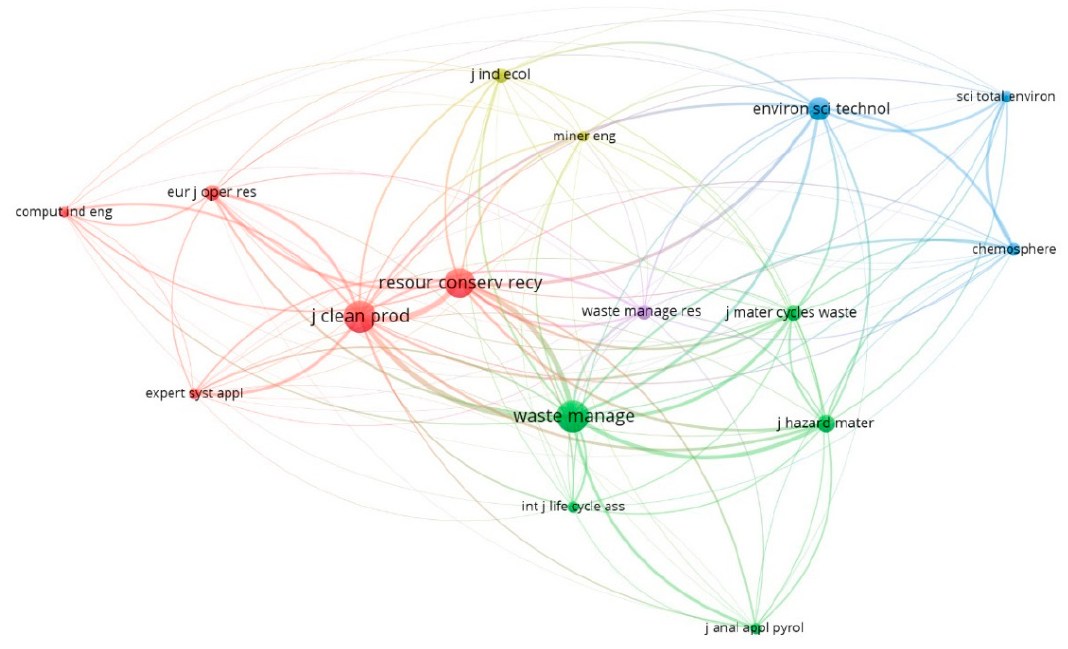
Figure 5. Journal co-citation network visualization map.